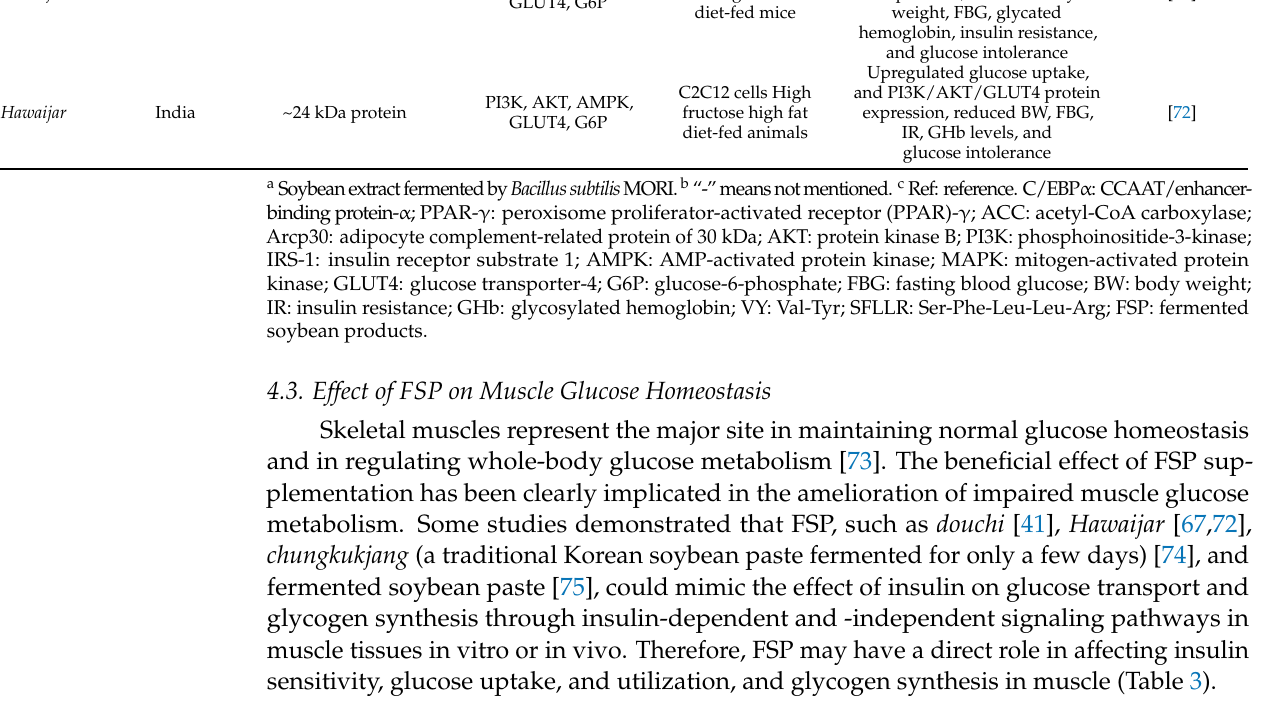
Table 3. The mechanisms of modulating the effect of FSP on glucose homeostasis in muscle